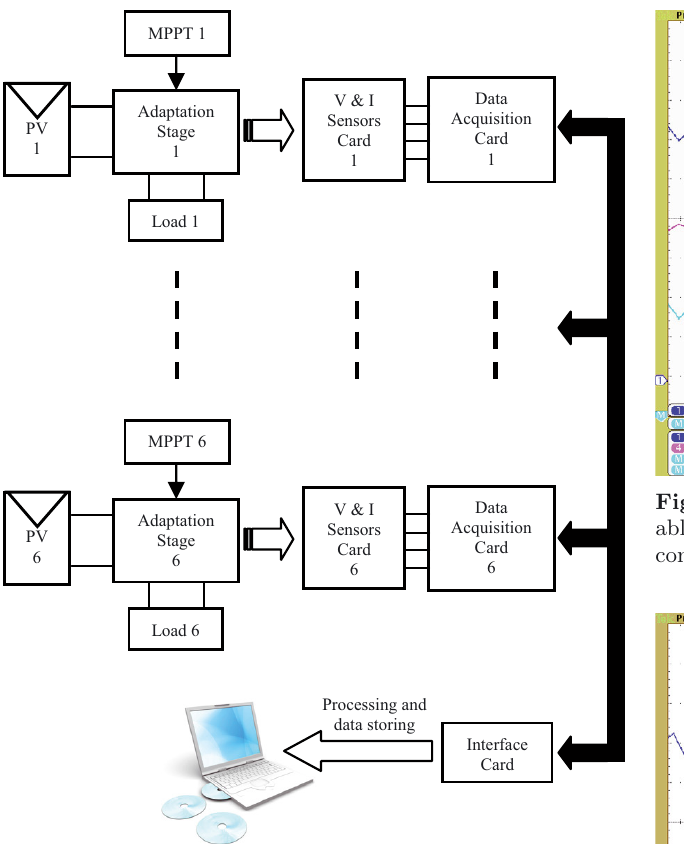
Fig. 3. Block diagram of the developed test bench.